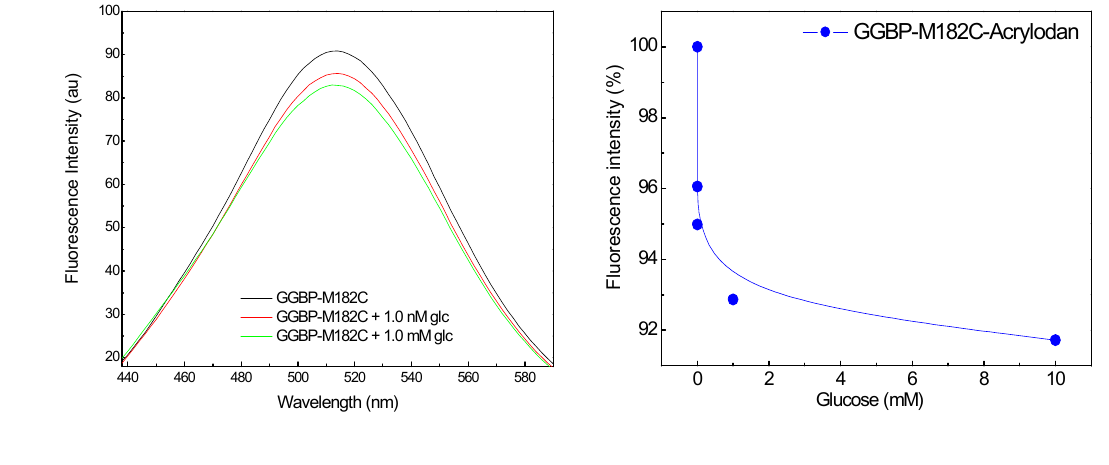
Figure 2. Left) Fluorescence glucose dependence of GGBP-M182C; Right) Titration curve with increasing amount of